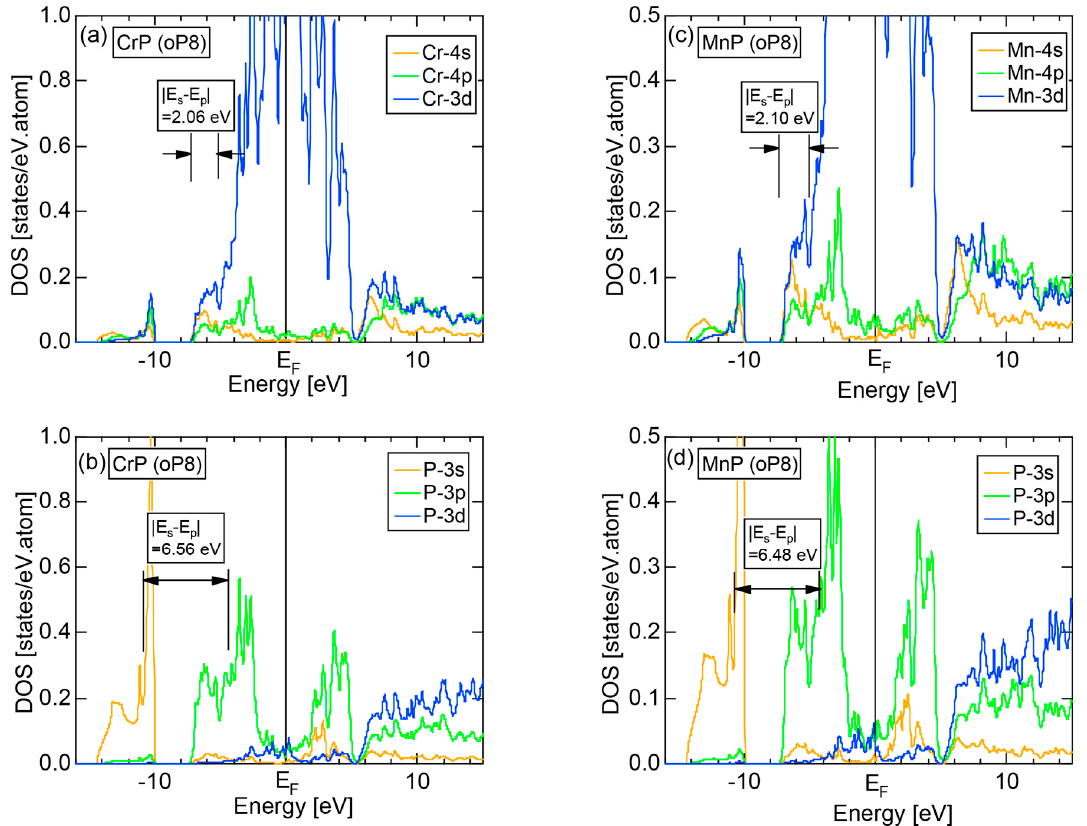
Figure 81. ( a ) Cr- and ( b ) P-pDOSs for CrP (oP8) and ( c ) Mn- and ( d ) P-pDOSs for MnP (oP8) [11]. The corresponding separation energies are also indicated in (a) to (d).